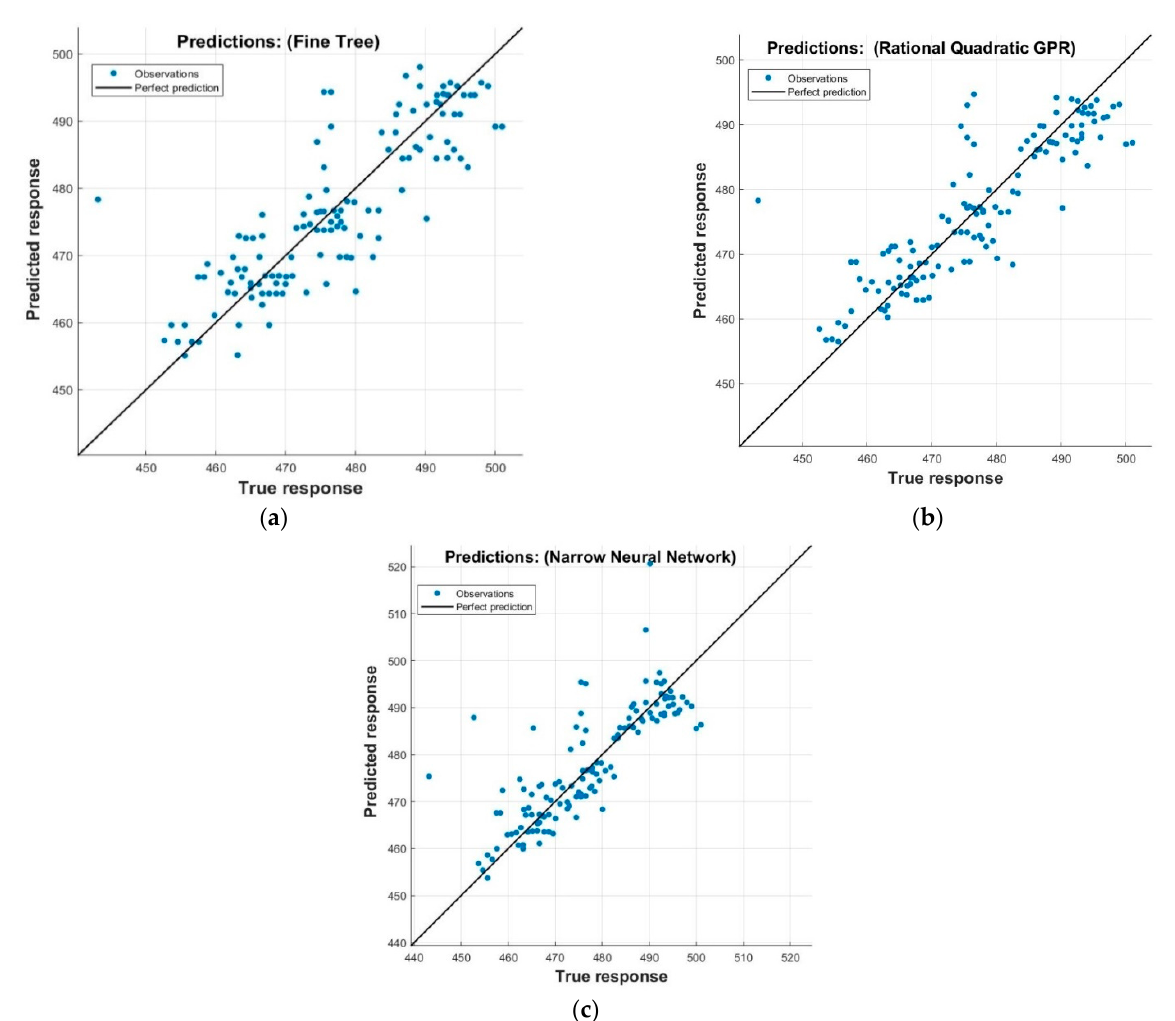
Figure 9. True vs predicted response. ( a ) GPR, ( b ) regression trees, ( c ) ANN.